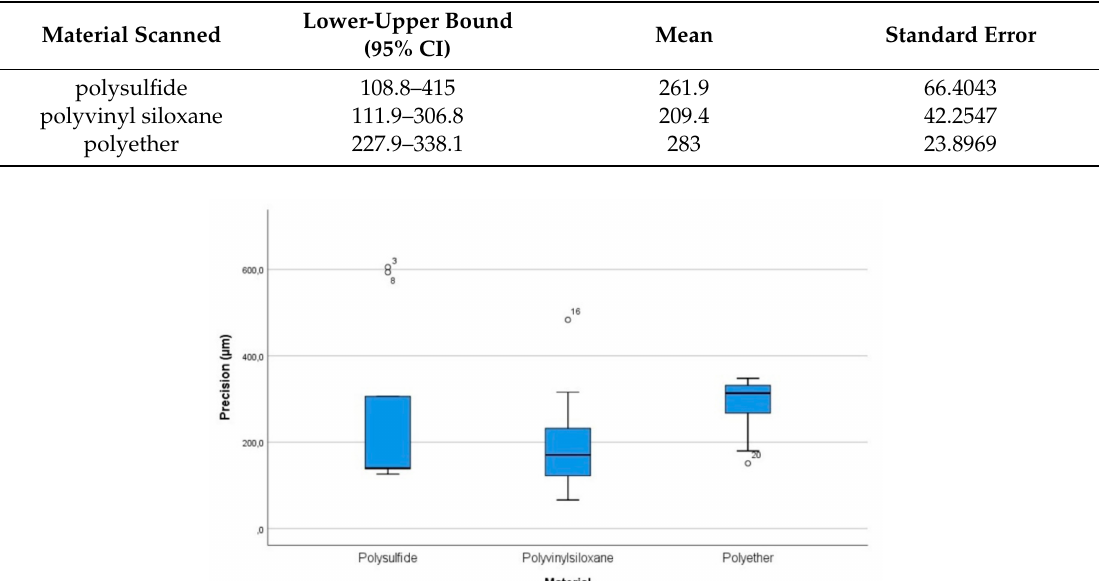
Table 2. Descriptive statistics for precision ( µ m).